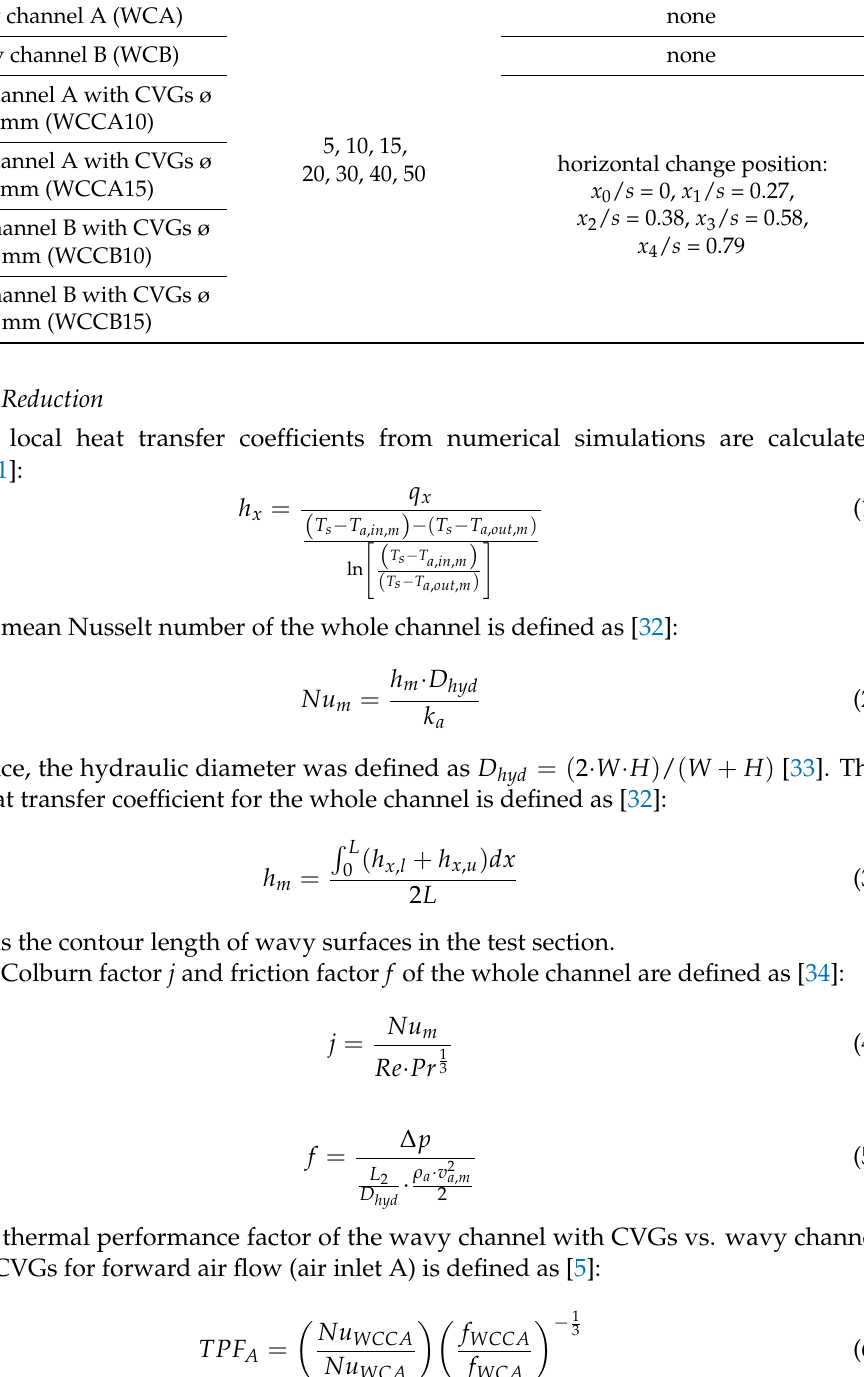
Table 1. Examined configurations and positions of the cylindrical vortex generators (CVGs). Configuration Q (m 3 /h) Cylindrical Vortex